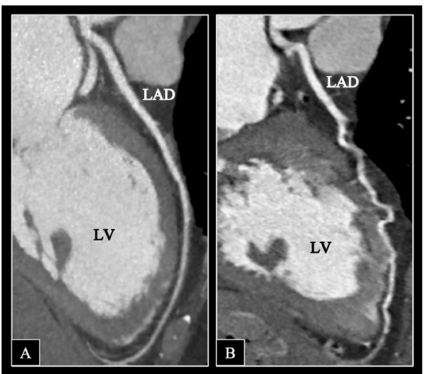
Figure 4. Curved multiplanar reconstruction images of the left anterior descending artery (LAD) of a patient visualized using DCCT ( A ) and a matched MDCT subject ( B ). ( A ). 61-year-old female patient with an average heart rate of 68 bpm during coronary CT angiography. LAD is depicted with no visible motion artifacts present (Likert score: 4). ( B ). Substantial motion artifacts limit the interpretability of the LAD in a 59-year-old female patient with a bpm of 67/min (Likert score: 2). DCCT, dedicated cardiac CT; MDCT, multidetector CT; bpm, beats/min; LV, left ventricle. LAD, anterior descending; LCX, left circumflex; RCA, right coronary